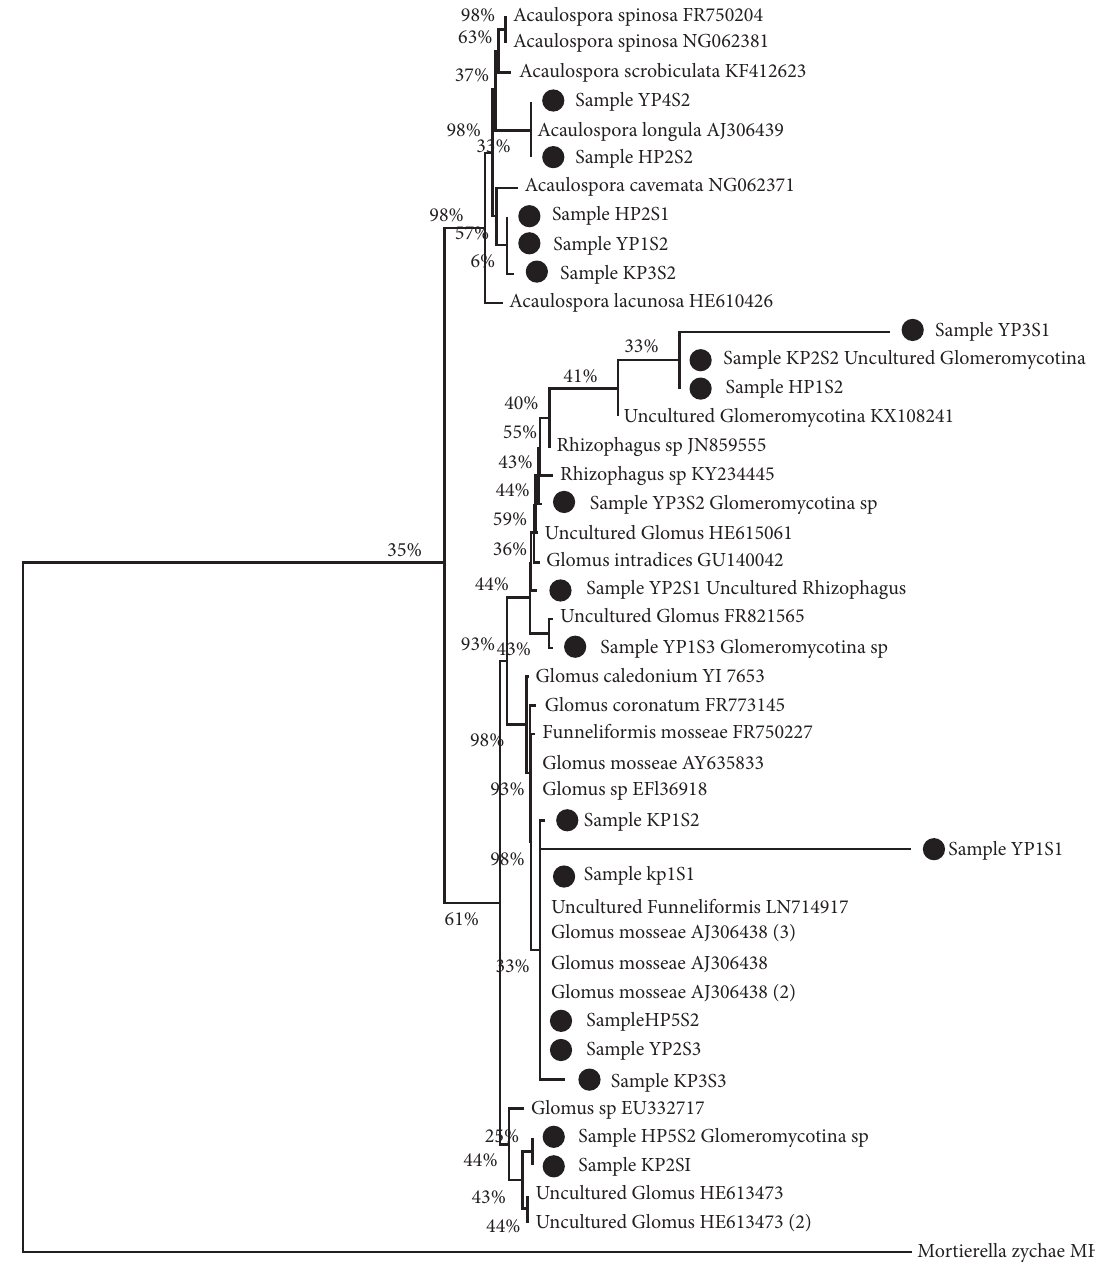
Figure 5: Phylogenetic tree generated using MEGA X by maximum likelihood method and Tamura–Nei model showing sequences of SSU rDNA of AMF from C. edulis roots (in bold